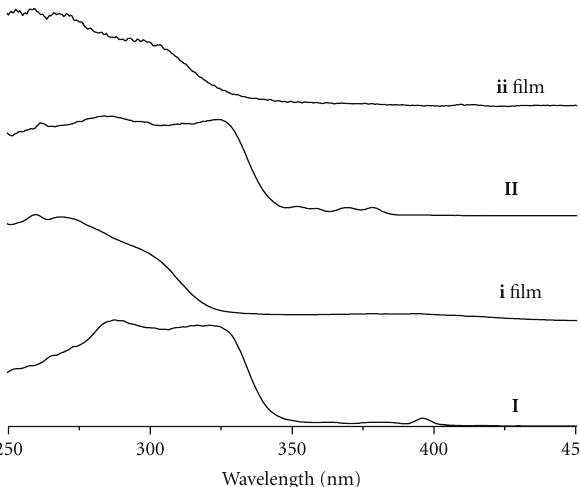
Figure 11: Normalized excitation spectra of Eu 2 (tph) 3 (H 2 O) 4 (I) , Tb 2 (tph) 3 (H 2 O) 4 (II) , i film , and ii film ( λ em = 612nm for I and i film, λ em = 545 nm for II and ii